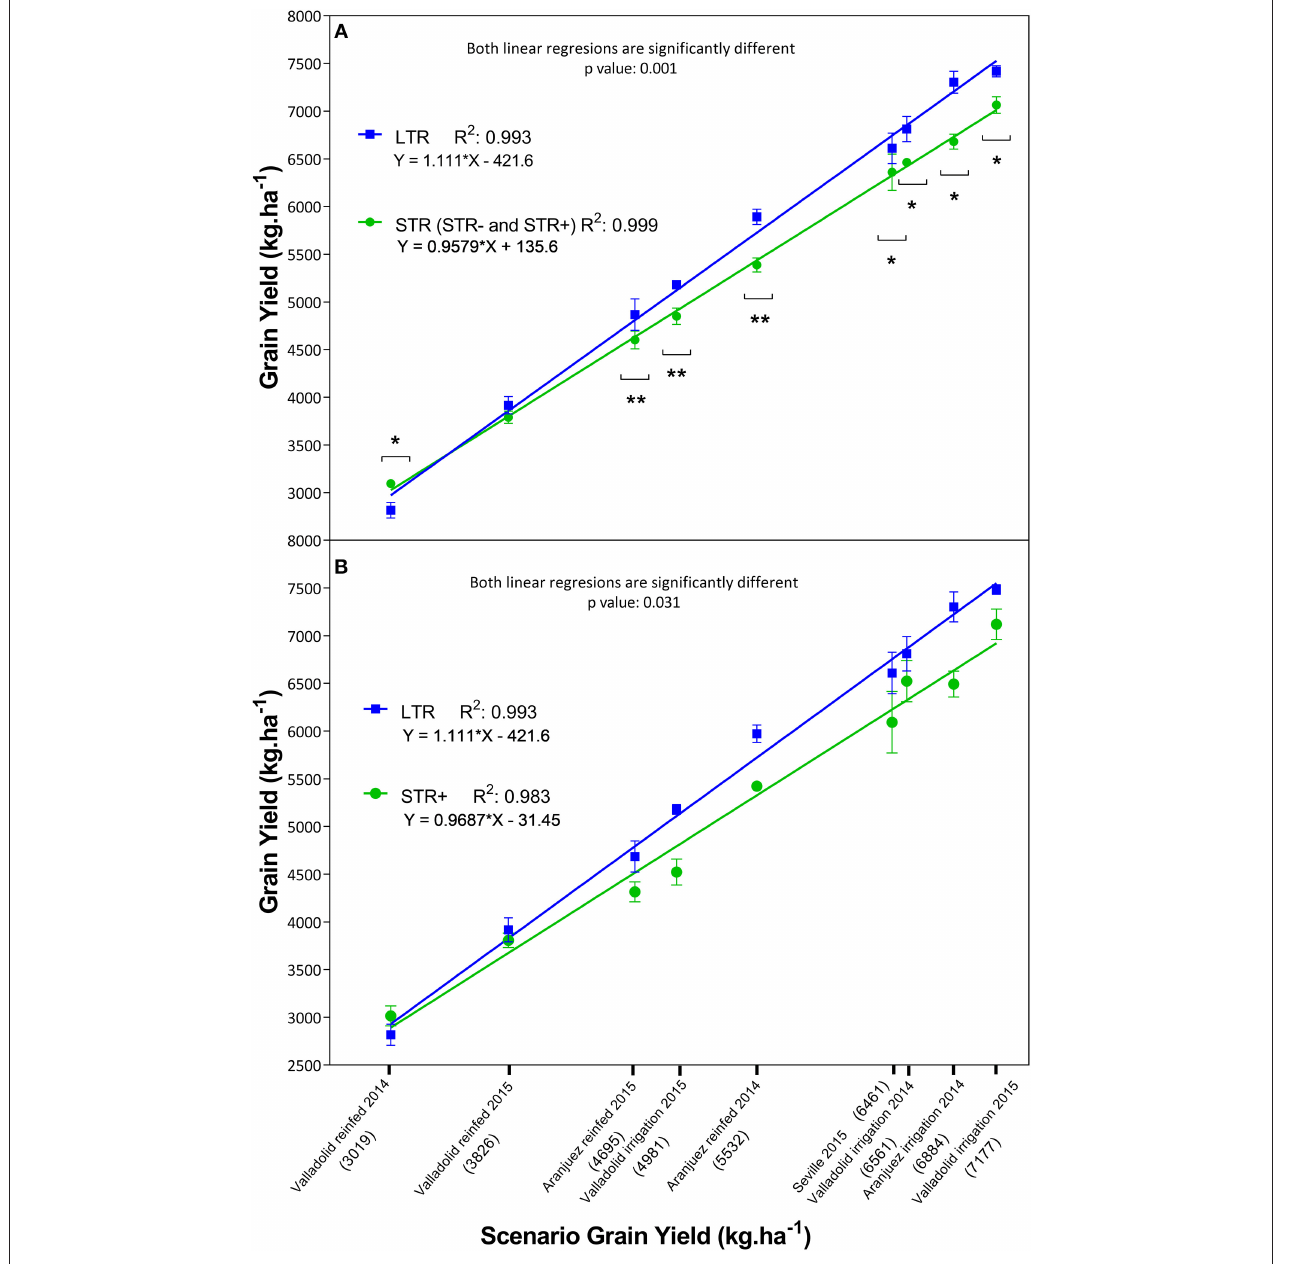
FIGURE 2 | Grain yield differences between the segmented transpiration (STR: including less segmented transpiration, STR − and very segmented transpiration, STR + ) and linear transpiration (LTR) lines across nine different growing conditions in the field. The X-axis presents the mean yield values of the complete set of 20 lines within each of the 9 trials where the mean yield across lines is expressed within parentheses below the name of the trial, while the Y-axis exhibits the mean yield of each subset of lines. In (A) the linear regressions represent the grain yield of the LTR (blue squares) and STR (green circles) groups within each growing scenario. Asterisks indicate significant differences between the LTR and STR groups performed by ANOVA (* p < 0.05, ** p < 0.01). In (B) the linear regressions represent the average grain yield of the complete set of STR + and LTR lines. Each value represents the average of any of the two groups of lines, each line being the mean value of three biological replicates (plots) per growing condition (i.e., trial). The level of significance ( p ) between fitting lines as well as the determination coefficient (R 2 ) and the equation of each line are also indicated next to each